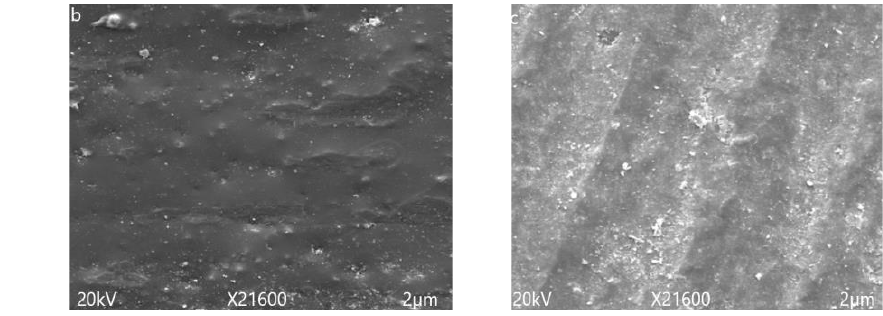
Figure 9. Scanning electron microscopy images of unaged samples. ( a ) neat epoxy, ( b ) EMC, ( c ) ENC.